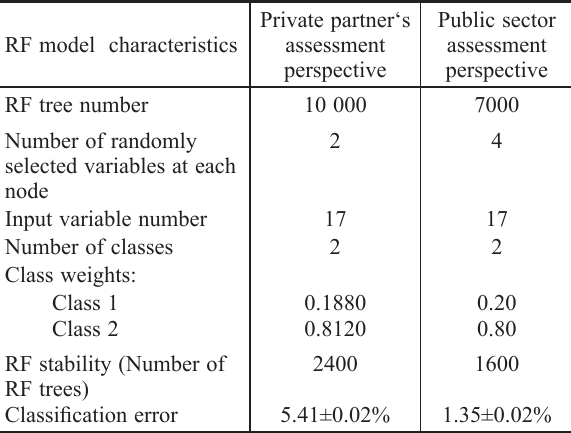
Table 4. The final research